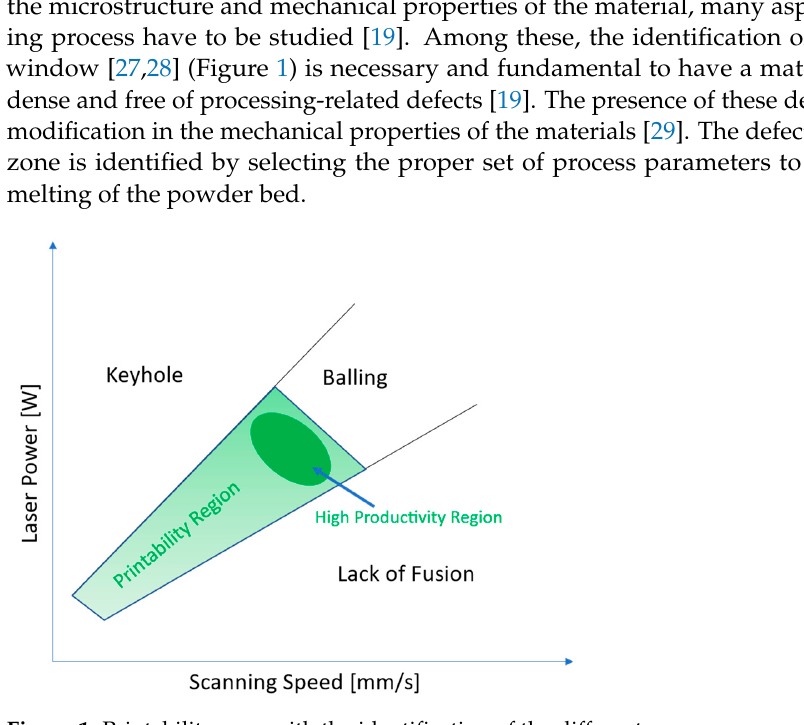
Figure 1. Printability map with the identification of the different zones.